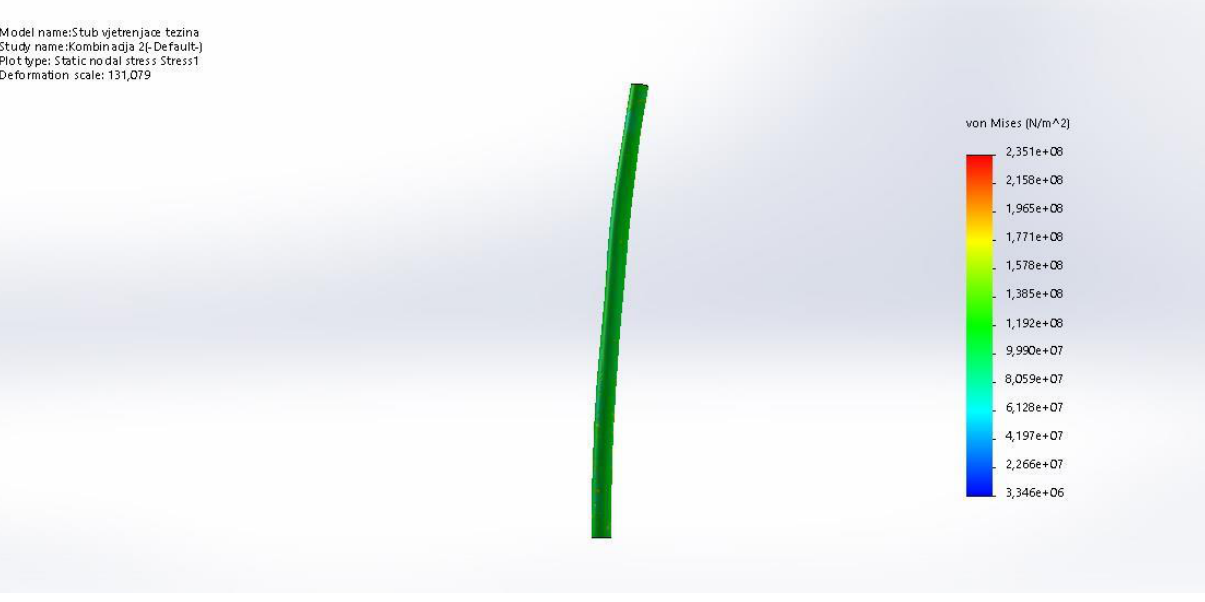
Figure 6. Stresses in wind turbine